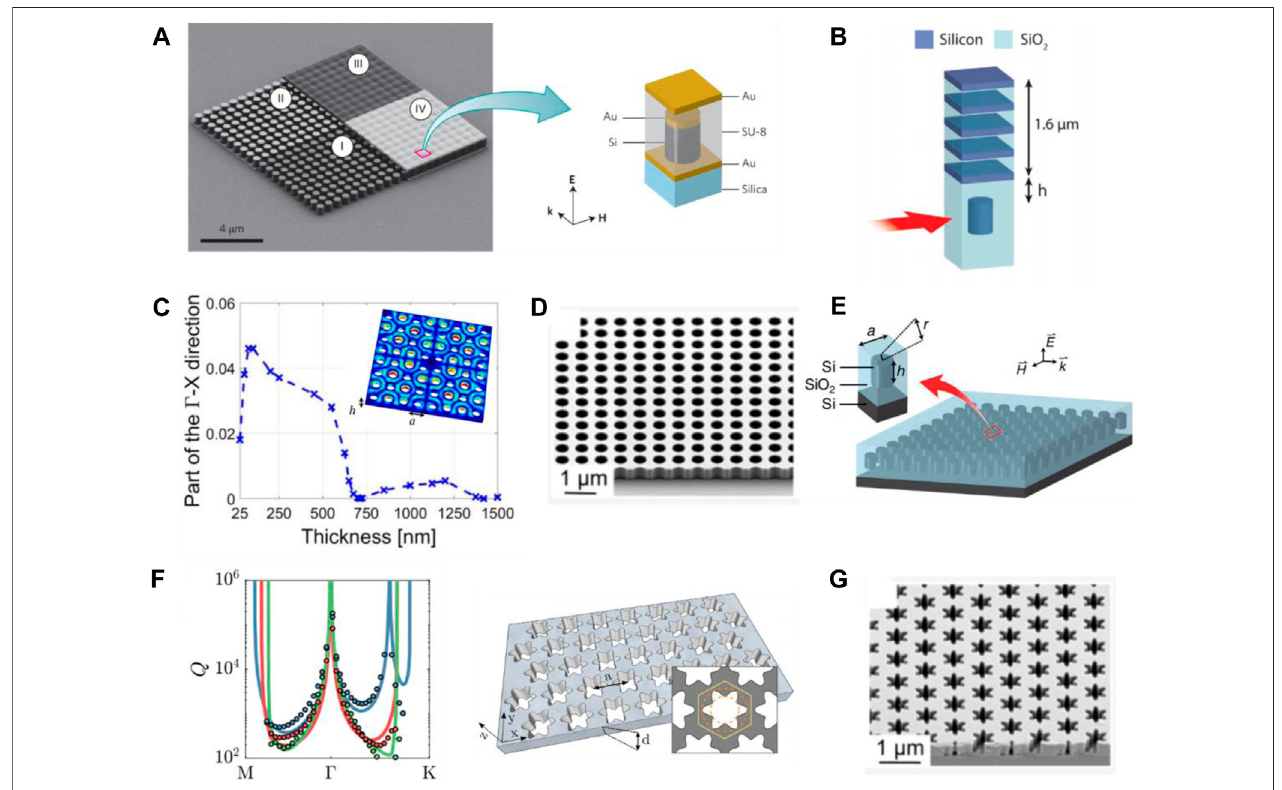
FIGURE 4 | (A) Scanning electron microscopy image of an on-chip PhC with a Dirac-like cone, and the schematic of unit cell. The cladding gold fi lms are used to eliminate theout-of-planeradiation. Reproduced withpermission from Ref.[138]. (B) Schematic ofBragg re fl ectordesignused tore fl ect the leaky waveback down into thepillars,whereitdestructivelyinterfereswiththeleakywavebelowthearray.ReproducedwithpermissionfromRef.[30]. (C) ExtentoftheringofEPsinthe Γ Xdirection versus the thickness of the PhC slab, which is illustrated by the inset. The radiative losses can be reduced using resonance-trapped BIC. Reproduced with permission from Ref. [140]. (D) Scanning electron microscopy images of a PhC slab with resonance-trapped BIC. A Dirac-like cone is formed due to the accidental degeneracy of a pair of dipole modes and a single quadrupole mode. Reproduced with permission from Ref. [147]. (E) Schematic of an on-chip PhC with resonance- trapped BIC. A Dirac-like cone is formed due to the accidental degeneracy of a single monopole mode and doubly degenerate dipole modes. Reproduced with permission from Ref. [146]. (F) Radiative quality factors for three photonic bands of a PhC slab illustrated by the right panel. A Dirac-like cone dispersion is obtained via symmetry-protected BIC without out-of-plane radiation. Reproduced with permission from Ref. [144]. (G) Scanning electron microscopy images of the PhC slab with symmetry-protected BIC. Reproduced with permission from Ref.